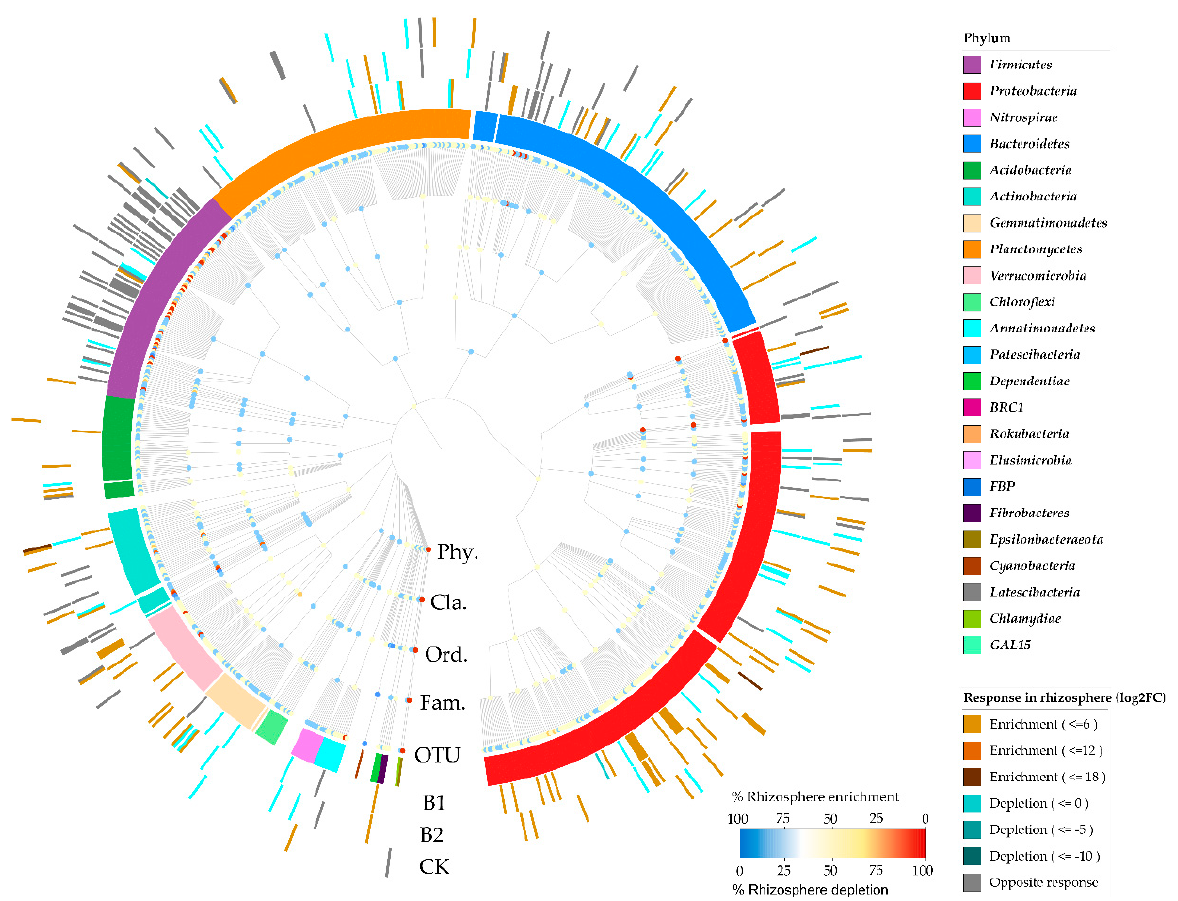
Figure 7. Taxonomic dendrogram displaying the log2 fold change in relative abundance with respect to soil treatments. Only the OTUs belonging to the most represented higher taxa (innermost circle) are shown. The three outermost rings indicate the number of soil treatments in which the relative abundance of an OTU was significantly higher (brown) or lower (green) in the rhizosphere communities under CK, B1, and B2 ( p < 0.05). The nodes in the cladogram indicate the phylum (Phy.), class (Cla.), order (Ord.), and family (Fam.) to which each OTU belongs. The color of the node represents the response consistency (measured as the percentage of OTUs enriched or depleted in the rhizosphere) within the subtree rooted at that node: consistent enrichment toward the rhizosphere is marked in red color, while consistent depletion is marked in blue color. Treatment abbreviations (CK, B1, and B2) are defined in Figure 2 caption.